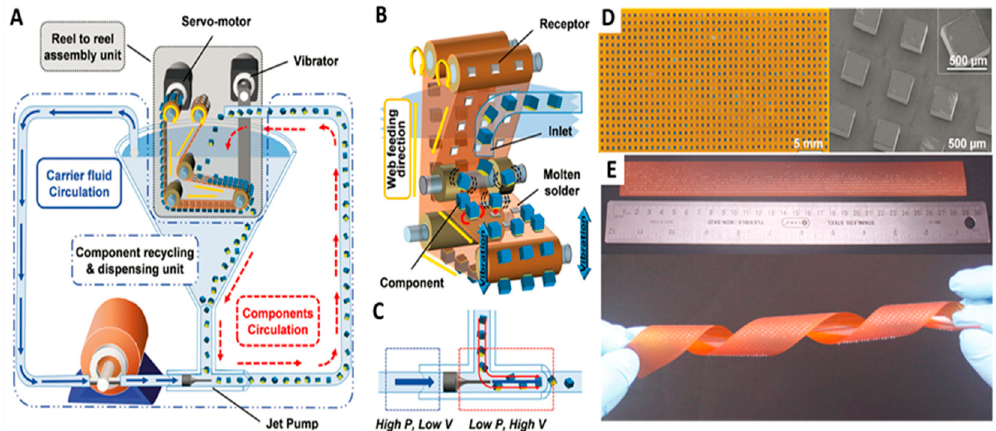
Figure 6. Automated reel-to-reel (RTR) fluidic self-assembly scheme. ( A ) Overview depicting (i) component dispensing on the basis of liquid flow and gravity, which transports the components to empty self-assembly sites (receptors) on a continuously advancing web, (ii) where the components attach at predetermined locations on the basis of surface tension directed self-assembly, and (iii) where recycling of access components is achieved on the basis of gravity at the turning point of the web before they are transported upward on the basis of a fluid drag inside a sufficiently-small-diameter channel. Mechanical up and down motion of the web is used to induce liquid flow and shear forces to dispense and agitate the components as well as to aid in the removal of access component in the region of the upside-down-oriented web. ( B ) Schematic depicting the details of surface tension directed self-assembly using molten-solder-bump-based-receptors to capture and connect to the metal contacts on the chips. ( C ) A jet pump-based principle is used to achieve recirculation of the chips without passing the components through a mechanical pump where they would get damaged. A preferred location of the jet pump is at the bottom of the slanted funnel where access components arrive on the basis of gravity to be picked up by a high velocity directional jet. ( D ) Periodic assembly onto 1.1 mm pitched square lattice points, 820 chips, 6 defects. Photograph and ( E ) Overview depicting continuous assembly onto a 2 cm wide and 29 cm long assembly region. Reprinted with permission from [42].